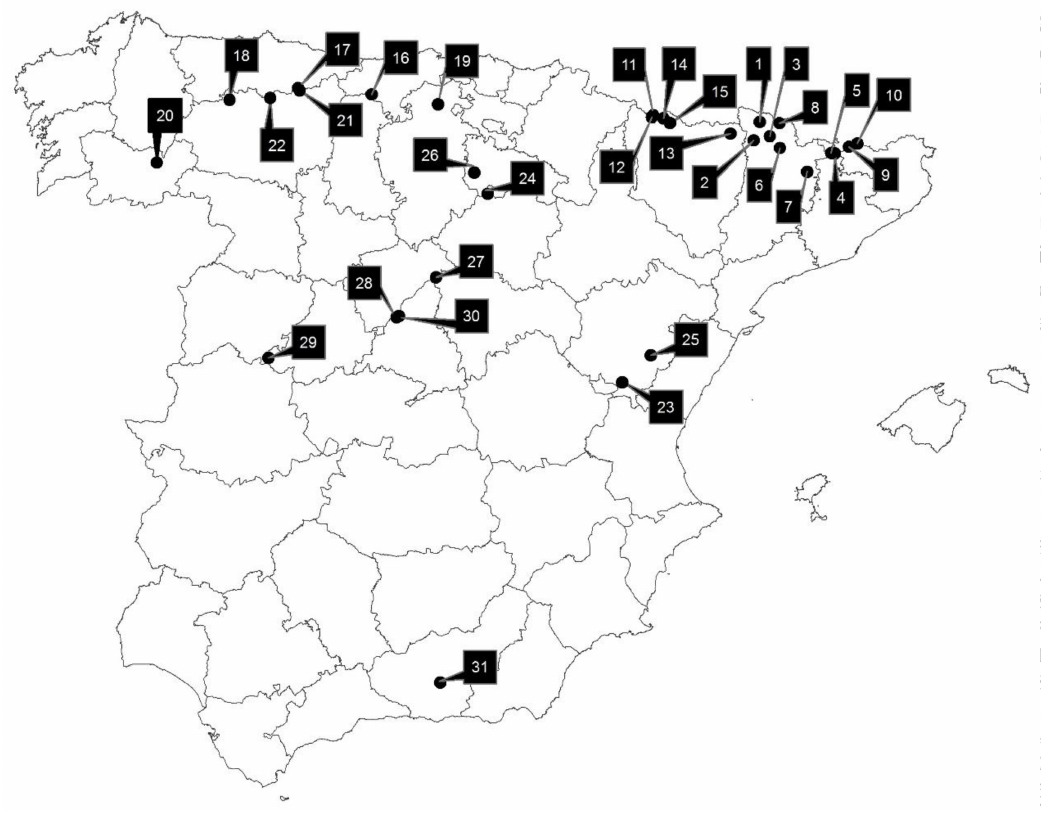
Figure 1. Map of alpine ski resorts of Spain. Legend: Catalan Pyrenees : 1. Baqueira Beret; 2. Bo í Taüll; 3. Espot Esqu í ; 4. La Molina; 5. Masella; 6. Port Ain é ; 7. Port del Comte; 8. Tavasc á n; 9. Vall de N ú ria; 10. Vallter 2000; Aragonese Pyrenees : 11. Ast ú n; 12. Candanch ú ; 13. Cerler; 14. Formigal; 15. Panticosa; Cantabrian Mountains : 16. Alto Campoo; 17. Fuentes de Invierno; 18. Leitariegos; 19. Lunada; 20. Manzaneda; 21. San Isidro; 22. Valgrande-Pajares; Iberian System : 23. Javalambre; 24. Punto de Nieve Santa In é s; 25. Valdelinares; 26. Valdescaray; Central System : 27. La Pinilla; 28. Puerto Navacerrada; 29. Sierra de B é jar; 30. Valdesqu í ; and Penibaetic System : 31. Sierra